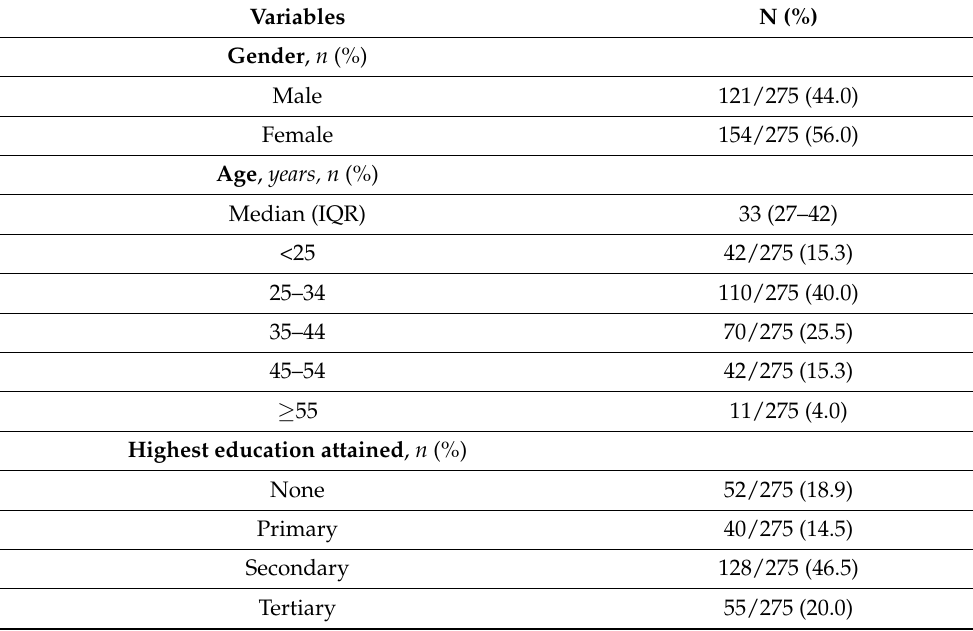
Table 1. Sociodemographic and clinical characteristics of study